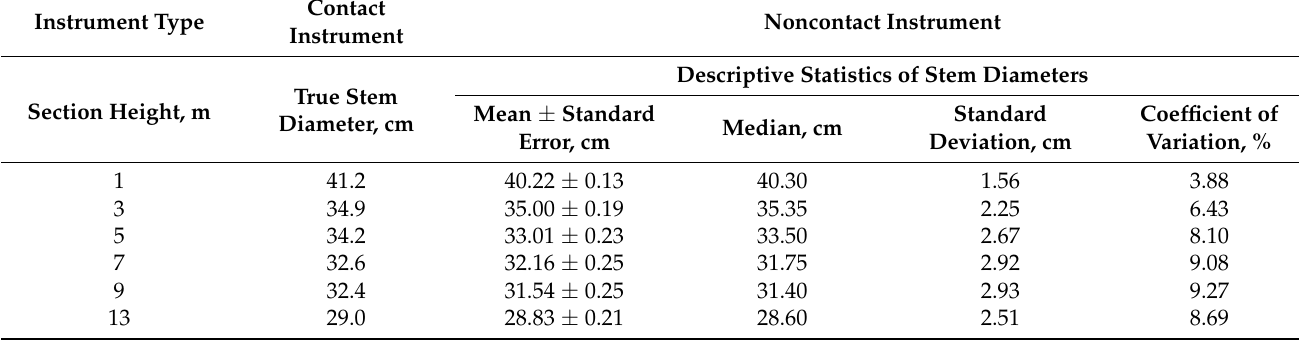
Table 1. True values and corresponding descriptive statistics of the upper-stem diameters measured with a laser